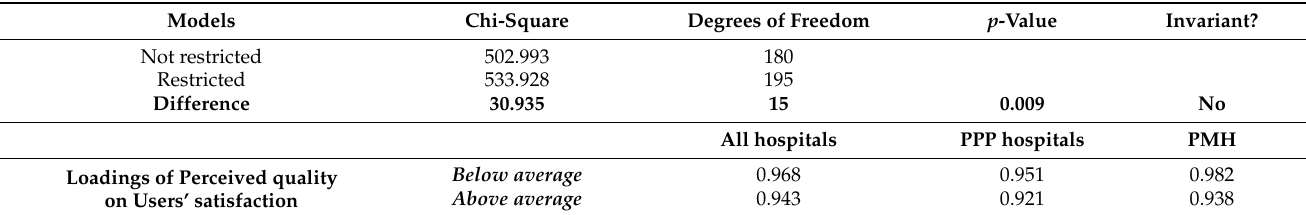
Table 9. Study of the moderator effect of literacy